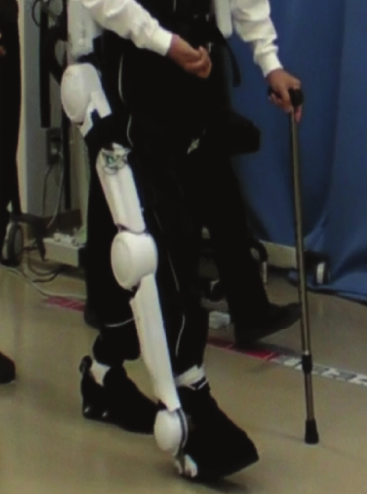
Figure 9: Single-leg version of HAL robot (picture courtesy of Professon Sankai, CYBERDYNE Inc./Univeristy of